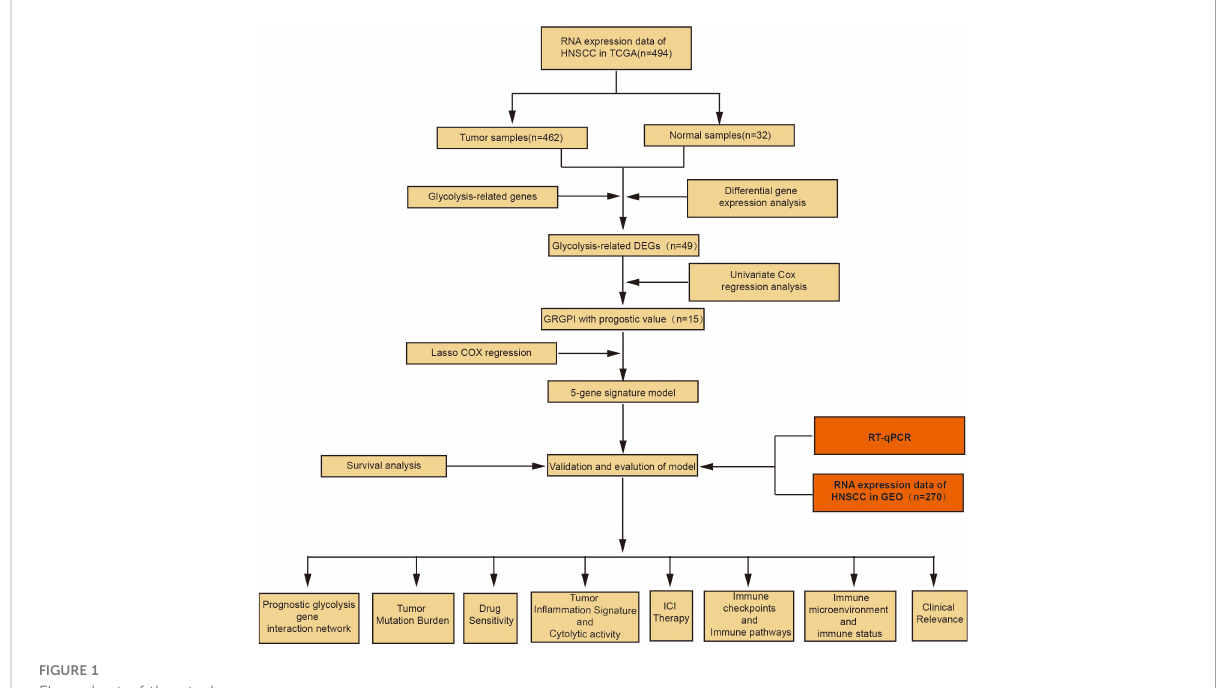
FIGURE 1 Flow chart of the study